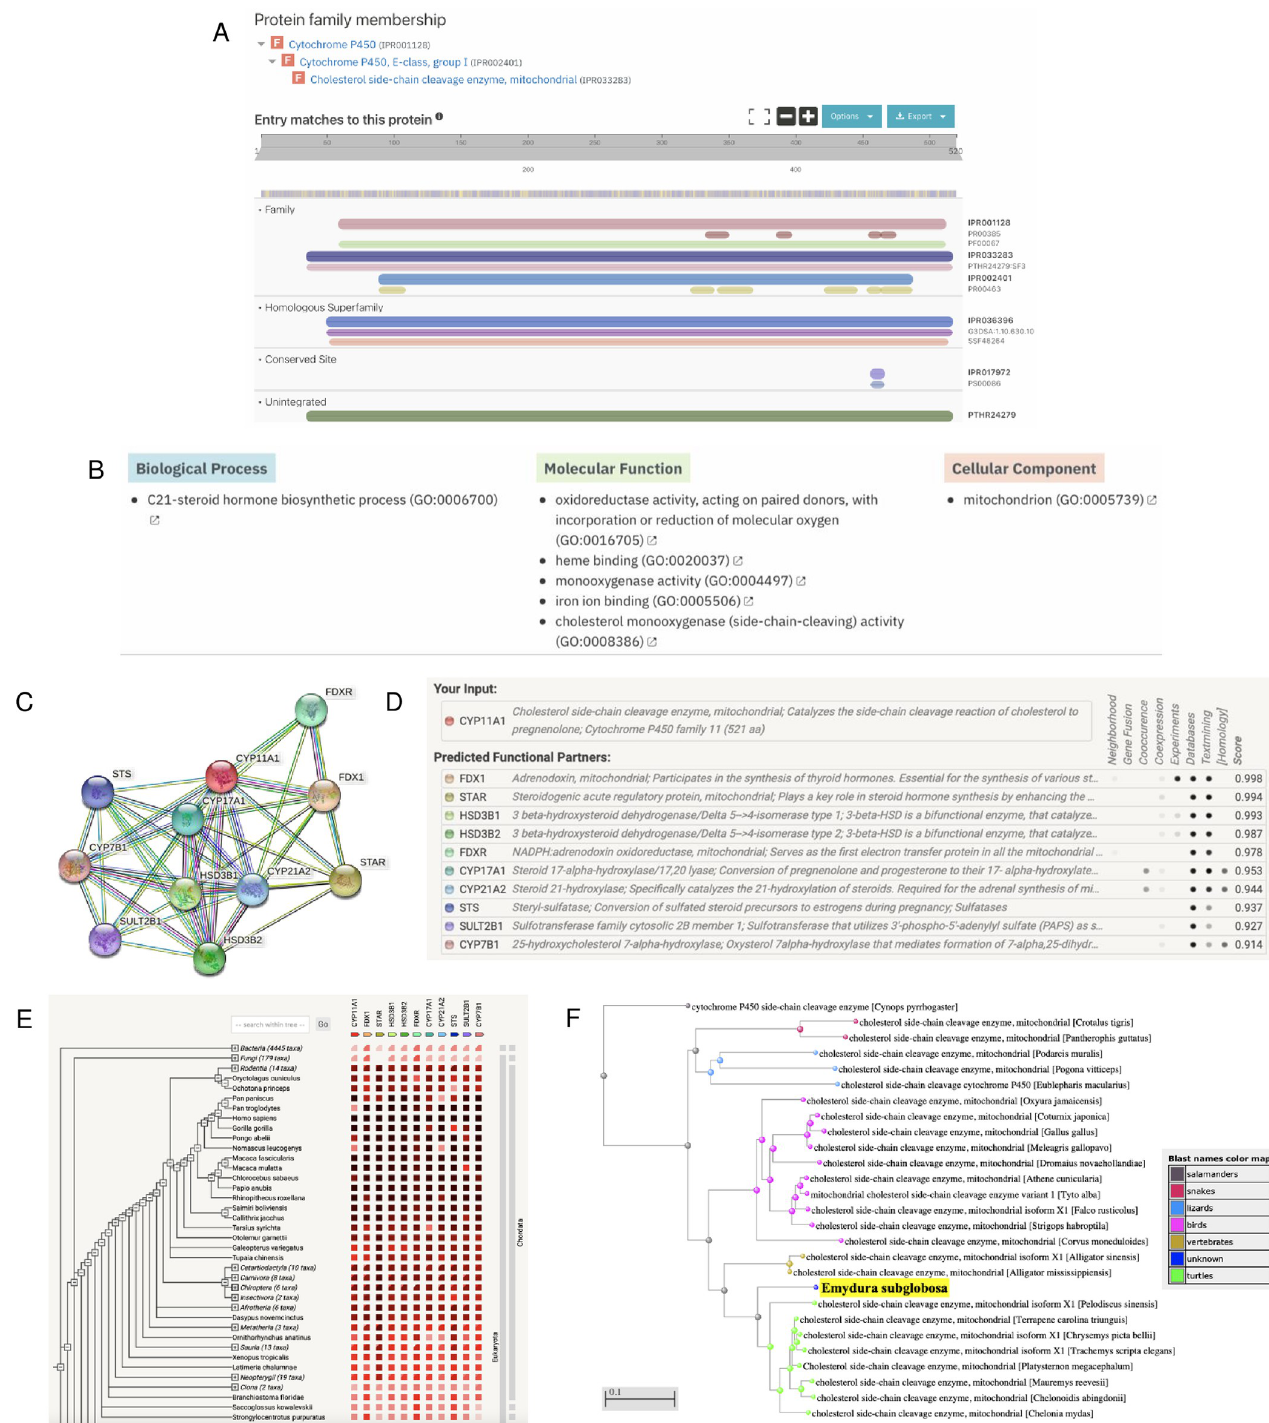
Fig 2. Functional analysis of the cholesterol side-chain cleavage enzyme. (A) InterPro functional analysis of the enzyme. (B) GO terms for the enzyme outputted by InterPro. (C) STRING network of predicted protein-protein interactions in H . sapiens . (D) List of functional partners predicted by STRING corresponding to C. (E) Gene co-occurrence of the protein. (F) BLAST phylogenetic tree built based on pairwise alignment.